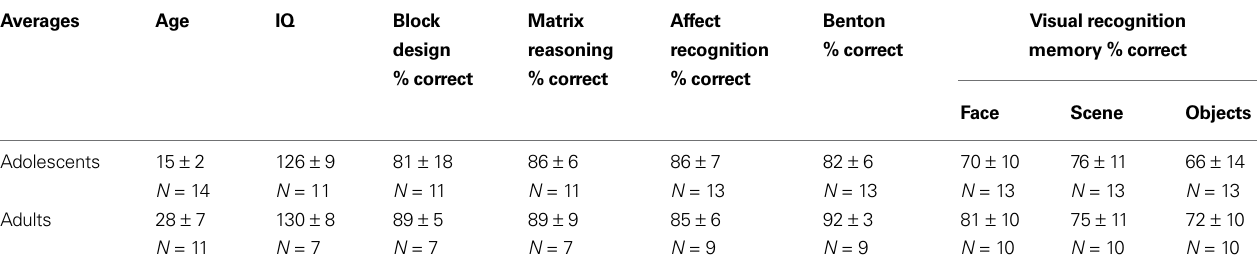
Table 1 | Subject demographic information and behavioral task performance: Data are split by age group. Sample size (N) is indicated for each measure (mean ± standard